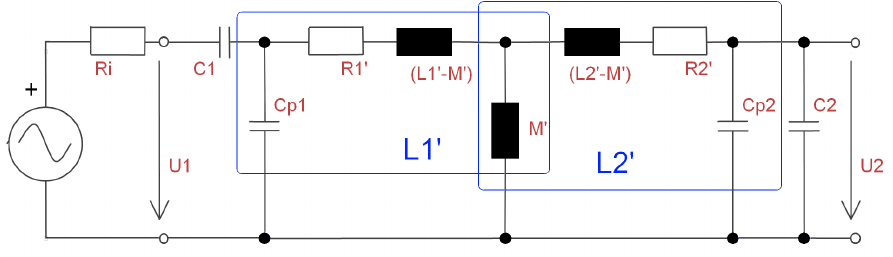
Figure 6. Schematic of typical inductive resonant transmission for the estimation of the transfer function, by using a modified transformer. L (cid:48) factors of the